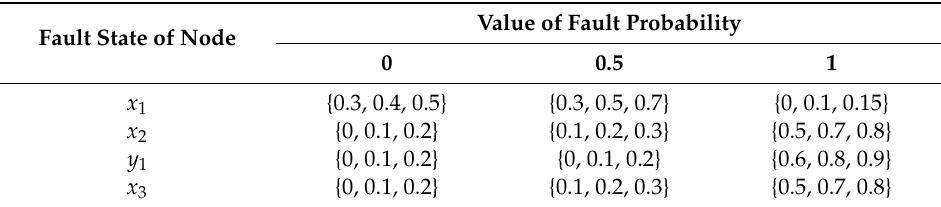
Table 4. Fuzzy numbers of fault states of root node